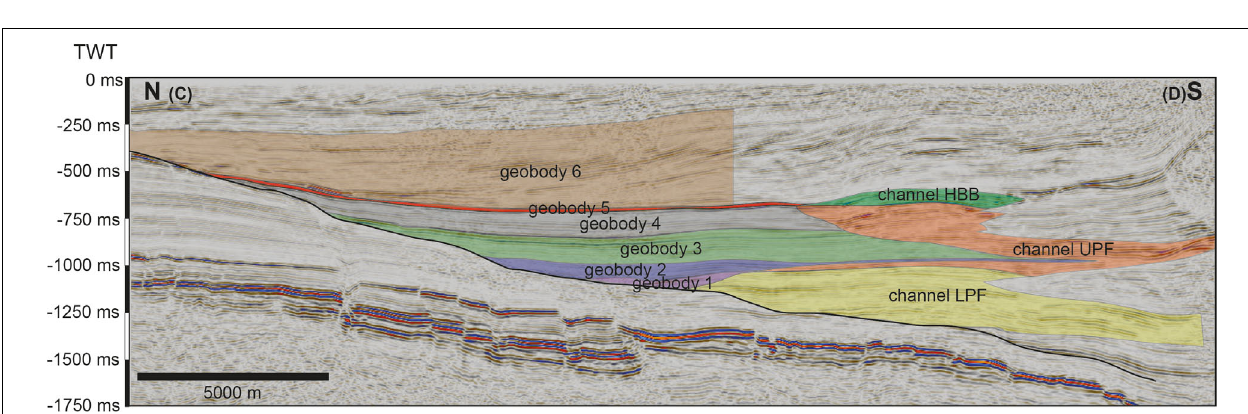
FIGURE 8 | Cross section (N – S) through the Upper Austrian Molasse Basin (for position see Figure 1 ) showing the extent of the geobodies in the channel and overbank model. Note the varying base area of the